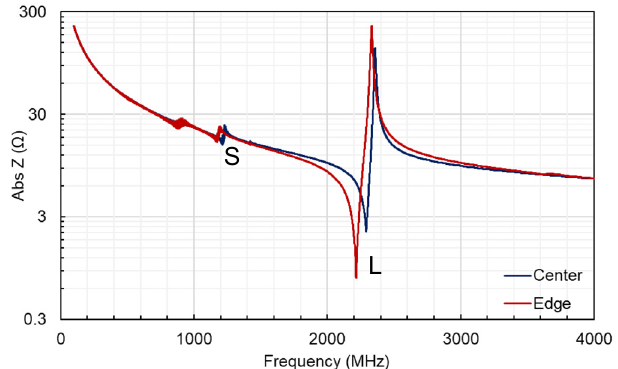
Figure 3. Frequency response of Al 0.7 Sc 0.3 N ‐ based SMRs located at position corresponding to the sample holder center and located at sample holder edge. Shear and longitudinal modes are labeled with an S and L, respectively.